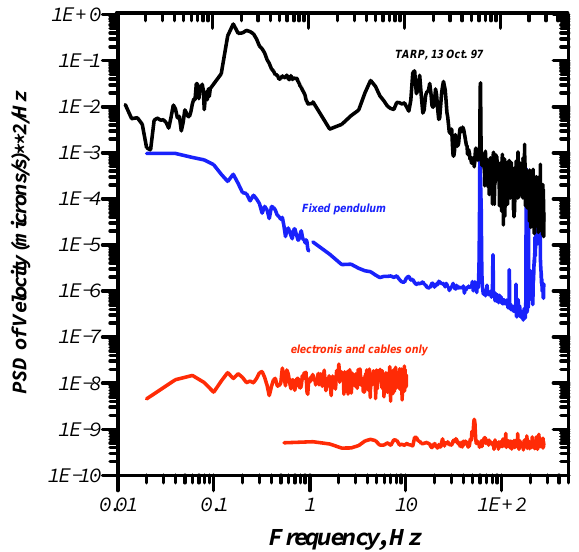
FIG. 1. (Color) Power spectral densities of vertical ground velocity measured by the SM3-KV probe in quiet condition (upper line), the same with fixed pendulum (middle), and equivalent noise of electronics only (two lower curves). disconnected from the DAS module preamplifier. Two curves correspond to the rms noise value of 0.5 nm (cid:121) s with sampling frequencies of 25 and 554 Hz.